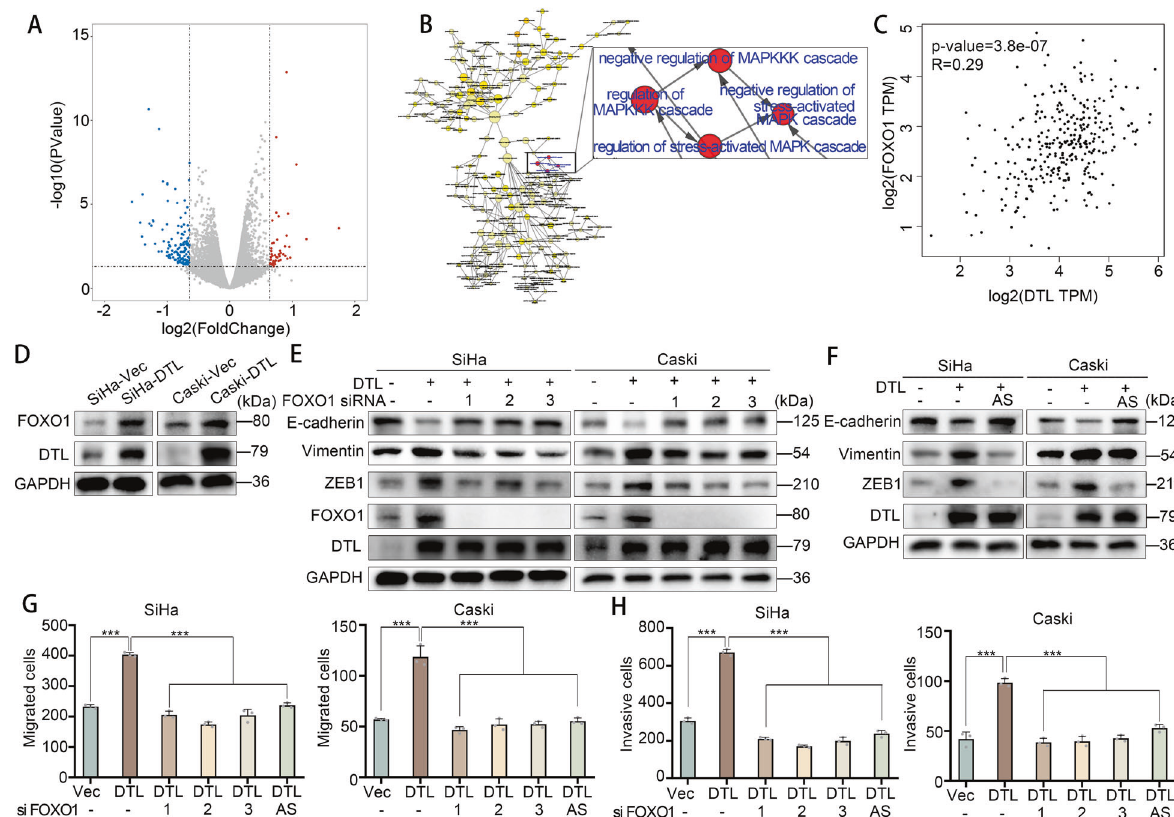
Fig. 3 DTL-induced EMT and cell migration and invasion through FOXO1. A Heatmap showing the top 200 up- or downregulated genes affected by DTL overexpression. B Enriched pathways for the top 200 genes associated with DTL in RNA-Seq assay including “ SAPK/JNK pathway. ” C FOXO1 expression is positively correlated with DTL through the TCGA database. D Western blotting demonstrated that DTL overexpression increases FOXO1 protein levels. E , F FOXO1 siRNAs ( E ) or FOXO1 inhibitor (AS1842856) ( F ) reduces DTL-induced EMT. G , H Quanti fi ed data of transwell migration ( G ) or invasion ( H ) assay in SiHa and Caski cells. Error bars indicate the mean ± SD of three independent experiments. Student ’ s t -test; * P < 0.05, ** P < 0.01, *** P < 0.001.